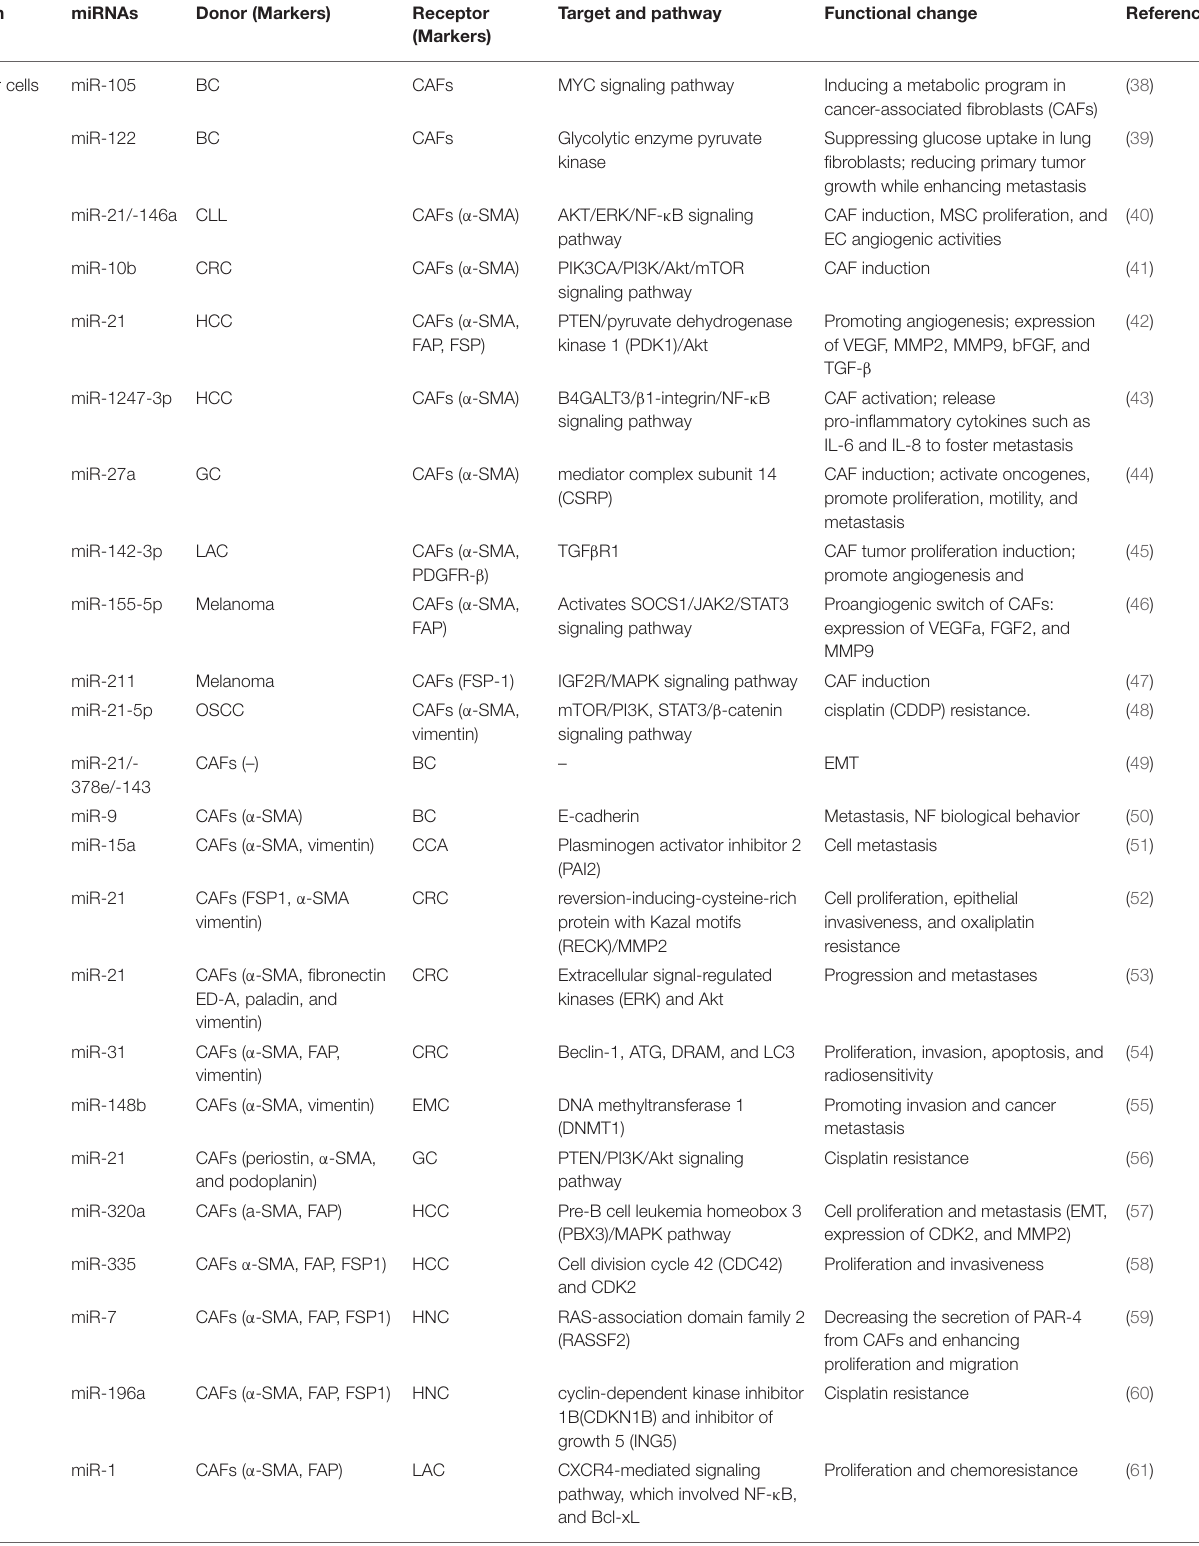
TABLE 1 | Exosomal miRNAs mediating the communication between tumor cells and CAFs.